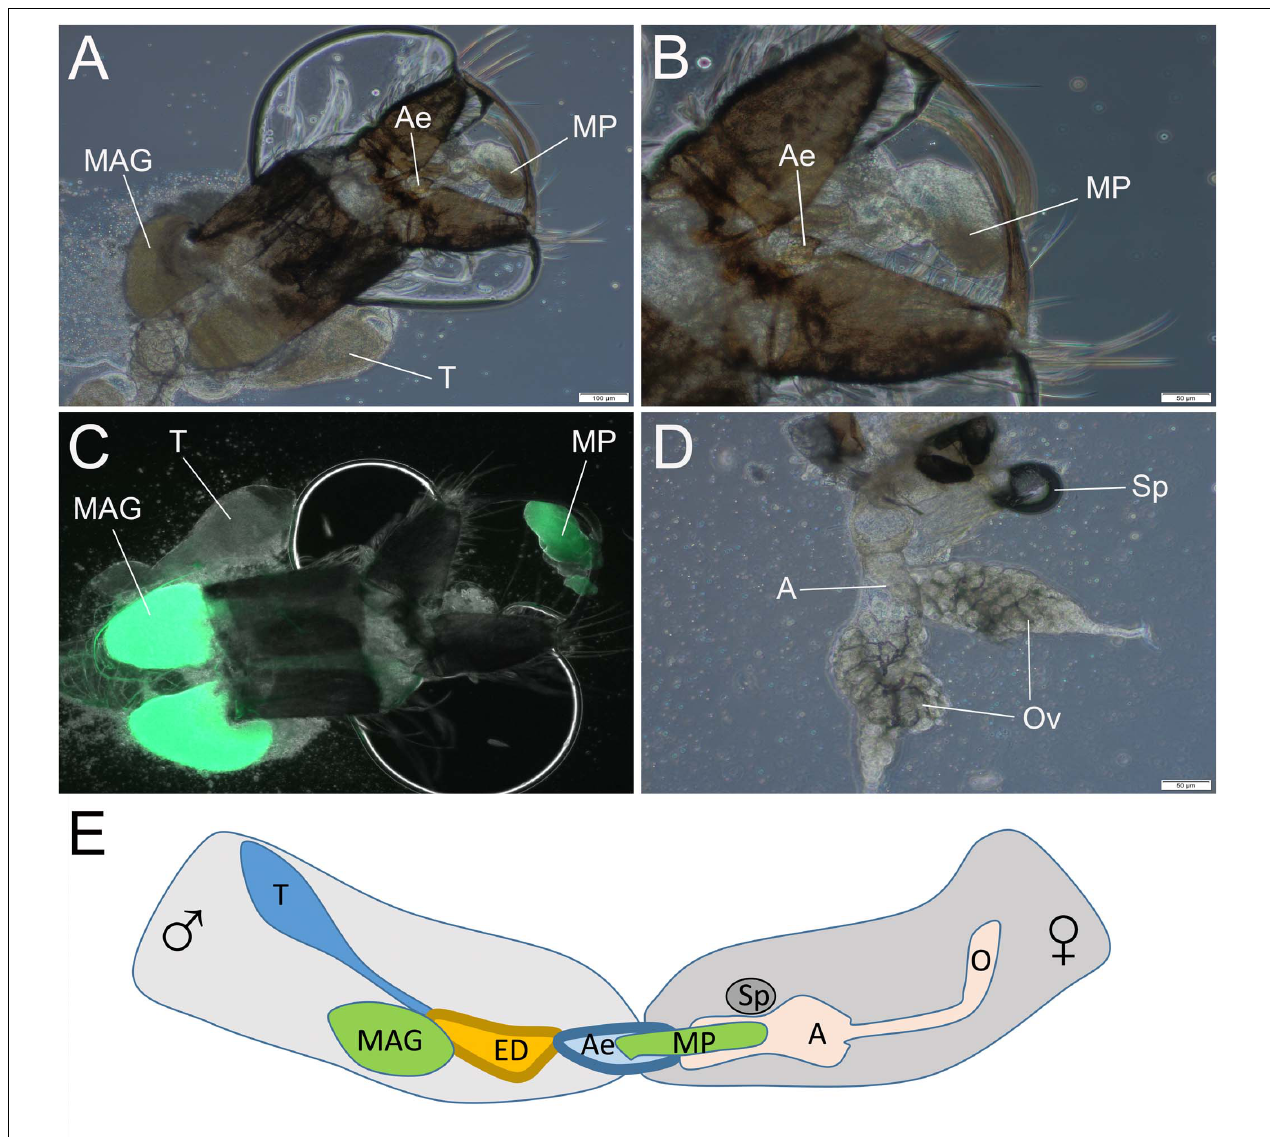
FIGURE 9 | The transfer of the mating plug from male into female during copulation. The observation is done by disruption of mating at 8–10 s after the start of copulation. (A,B) The mating plug attached to the aedeagus. (C) The autofluorescent mating plug. (D) Absence of the mating plug in the atrium of the mated female. (E) Scheme showing the mating plug transfer from male into female atrium at 8–10 s after the start of the mating process. T, testis; MAG, male accessary gland; ED, ejaculatory duct; Ae, aedeagus; MP, mating plug; A, atrium; and Ov, ovary. Scale bars are 100 µ m in (A,C) and 50 µ m in (B,D) .